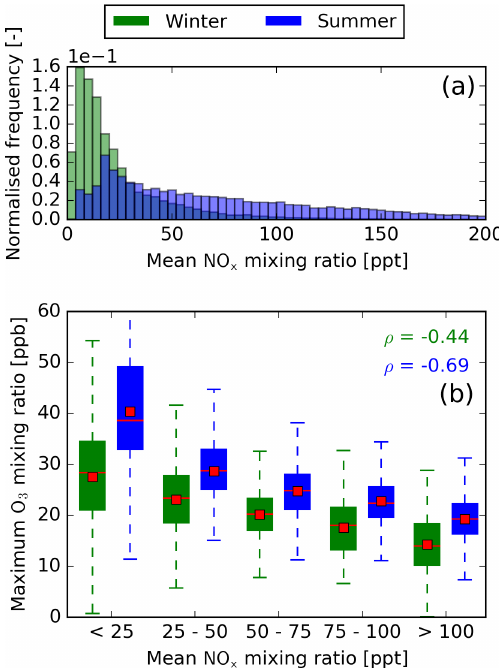
Figure 7. (a) Normalised histogram of the mean HO x mixing ra- tio until the O 3 maximum is reached. Results are normalised to the total number of air parcels in summer and winter, respectively. (b) Binned box plots showing the relation between the mean HO x mixing ratio and the magnitude of the O 3 maximum. Please note that during summer HO x mixing ratios below 0.5ppt show no sta- tistical significance. Therefore, no box plot is provided in this case. The median and mean for each box plot are represented by red lines and red boxes, respectively. Additionally, the Spearman rank coef- ficient is given for summer and